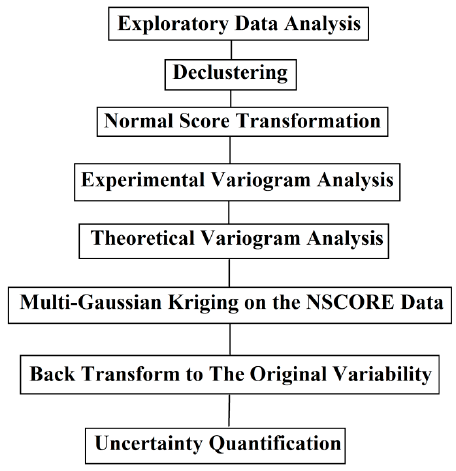
Figure 1. Schematic instruction for multi-Gaussian kriging. (NSCORE data: normal score transformation data).